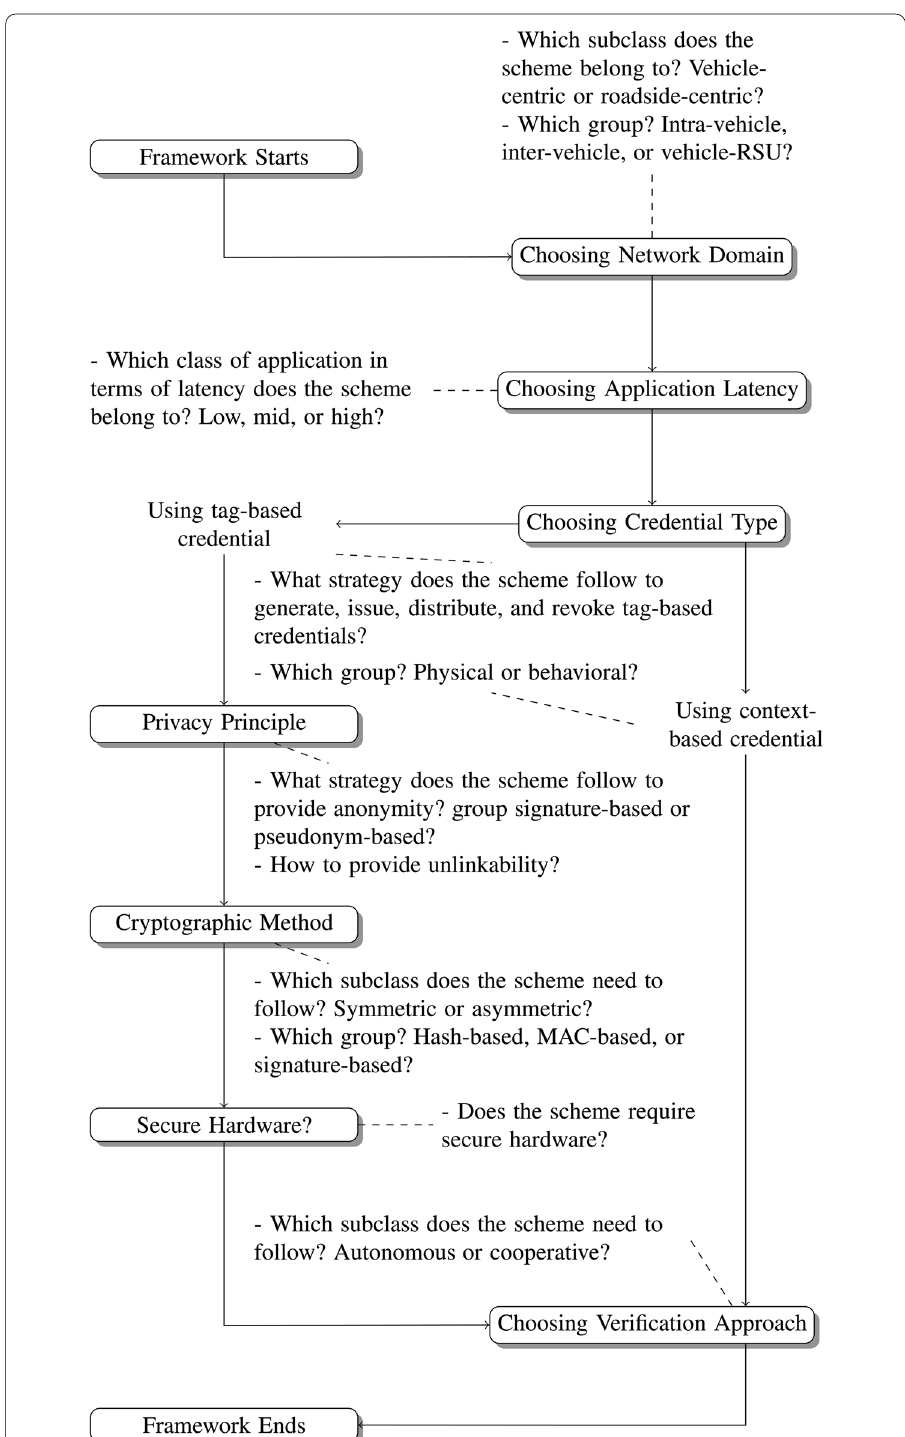
Fig. 15 Authentication framework based on our